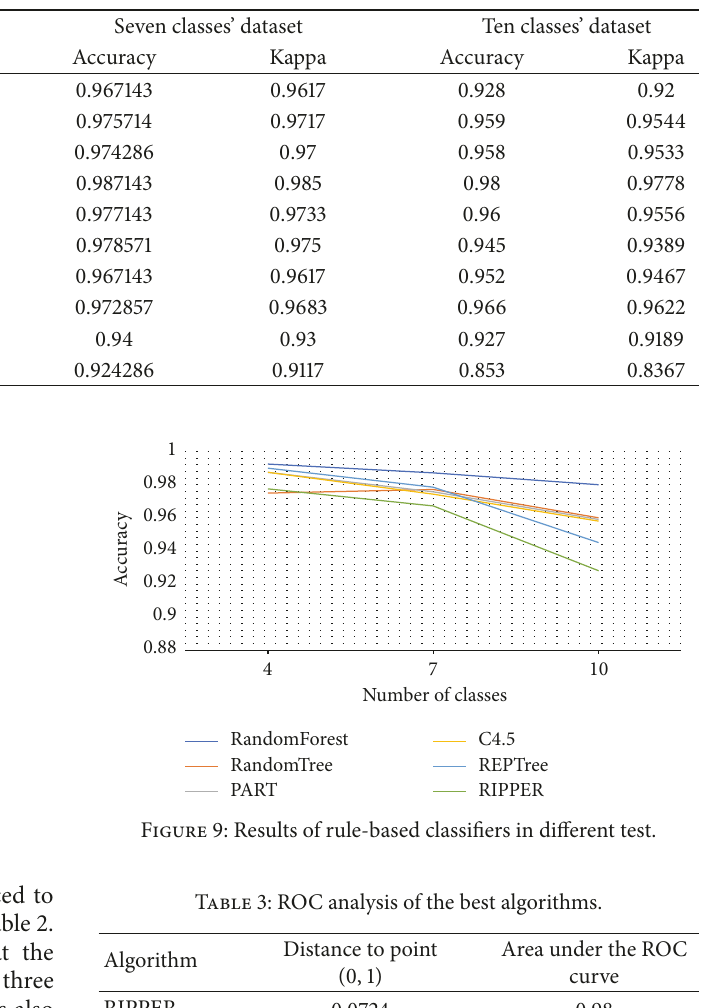
Table 2: Datasets results.